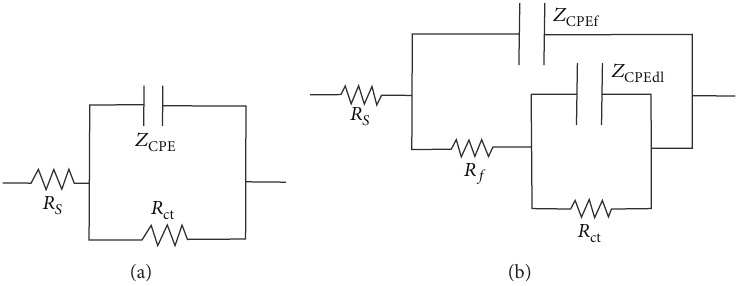
Figure 6: Equivalent circuits used to represent the impedance results: (a) base mixture, inhibitor A in base mixture, inhibitor B in base mixture, and CO 2 in base mixture; (b) CO 2 and inhibitor A in base mixture, CO 2 and inhibitor B in base mixture.